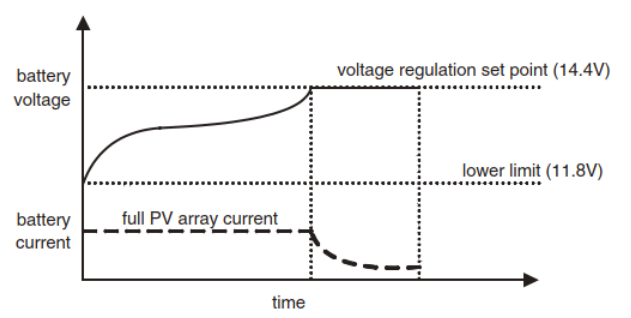
Figure 3 . two-phase charging mode.